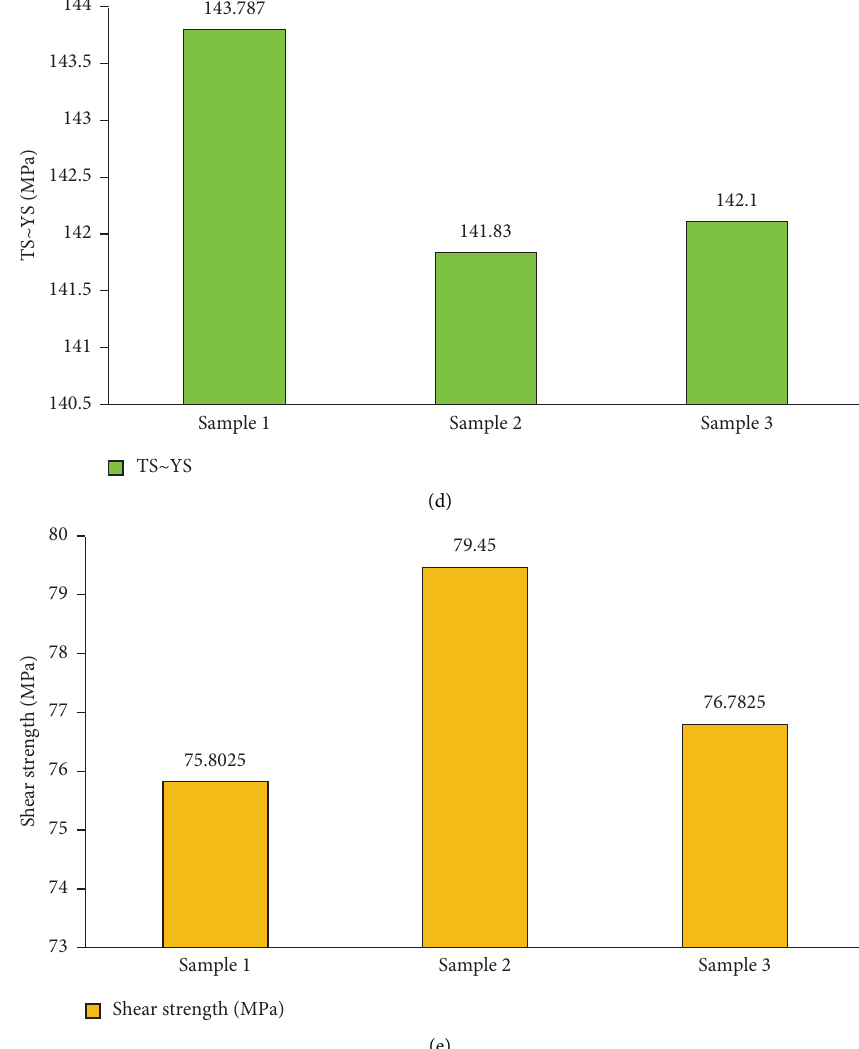
Figure 3: (a) Stress vs. strain curve for 3 specimens; (b) tensile and yield strength; (c) YS/TS ratio; (d) TS–YS variation; (e) estimated shear strength.